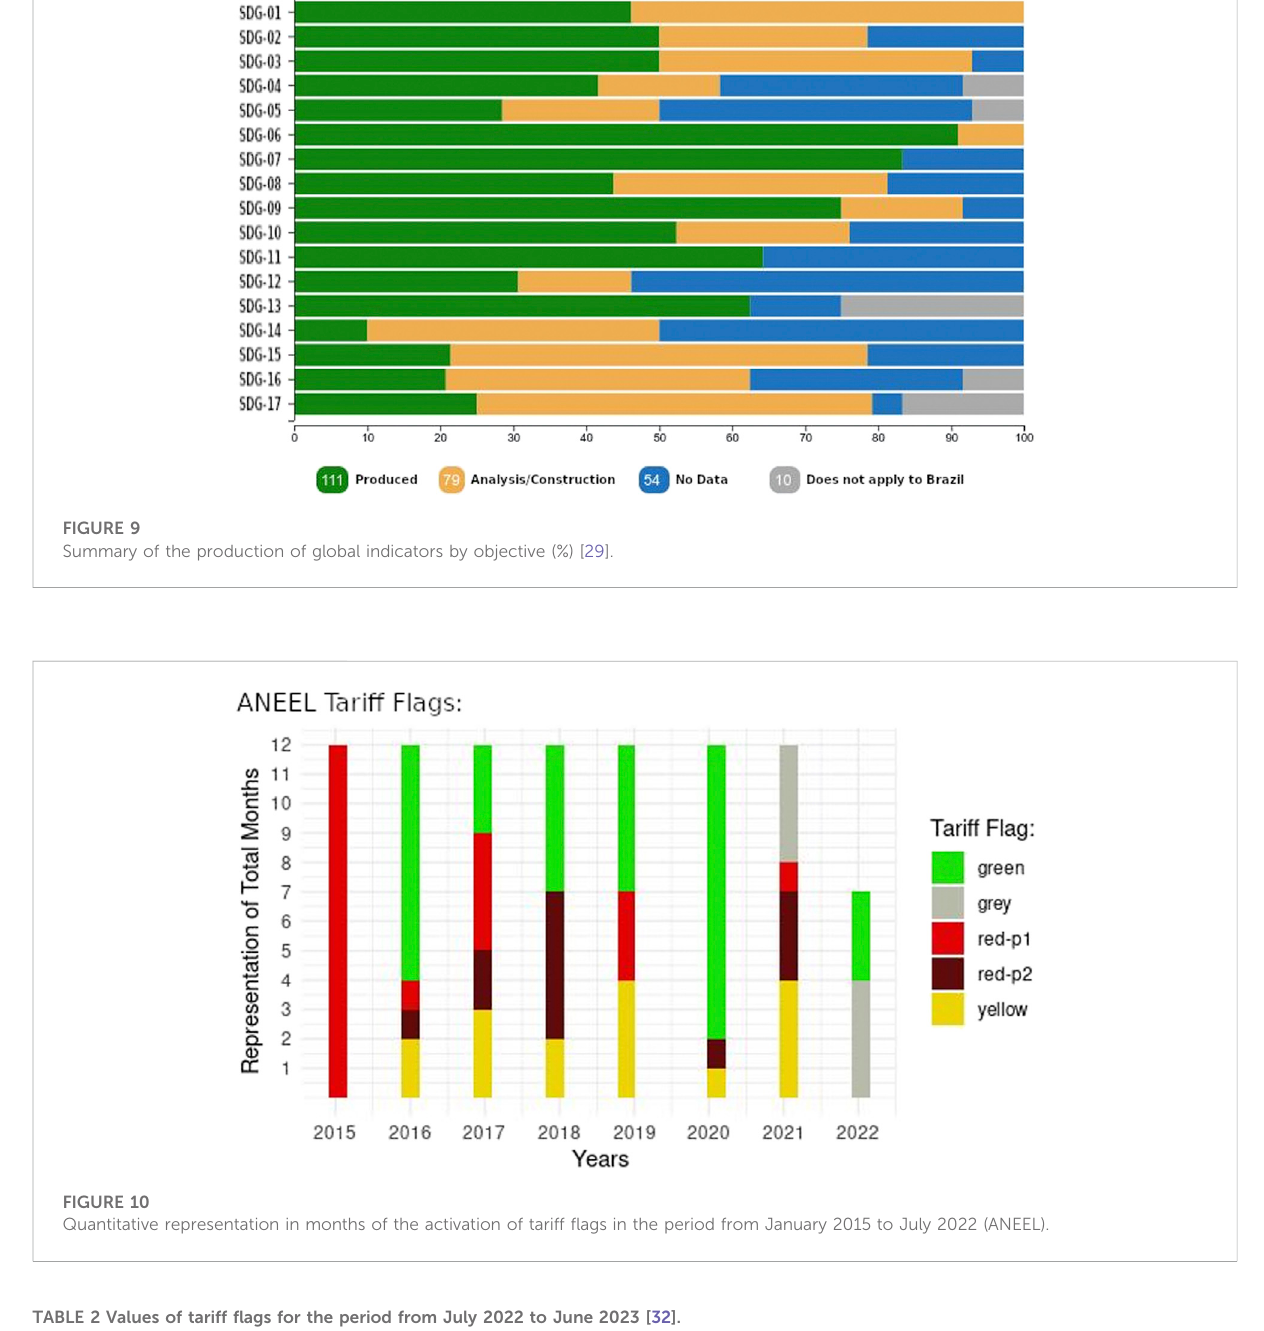
TABLE 2 Values of tariff fl ags for the period from July 2022 to June 2023 [32]. Flag Condition Cost per kilowatt-hours (kWh) Green Favorable generation conditions No additional cost Yellow Less favorable conditions BRL 2,989 for every 100 kWh consumed Red type 1 Unfavorable conditions BRL 6,500 for every 100 kWh consumed Red type 2 Very unfavorable conditions BRL 9,795 for every 100 kWh consumed Gray Water scarcity BRL 14.20 for every 100 MWh